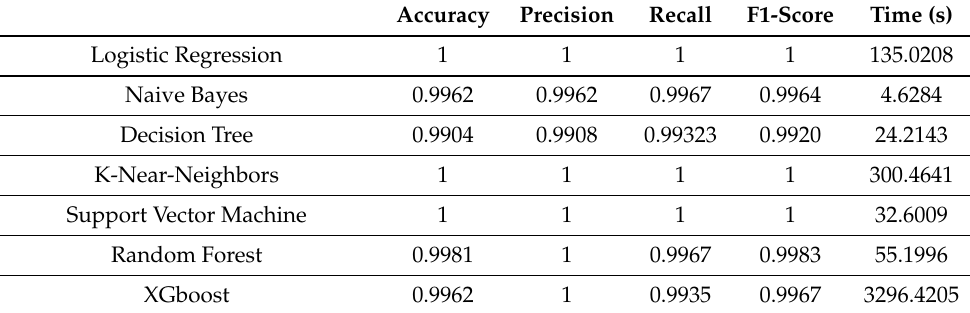
Table 9. Result of 75% attack